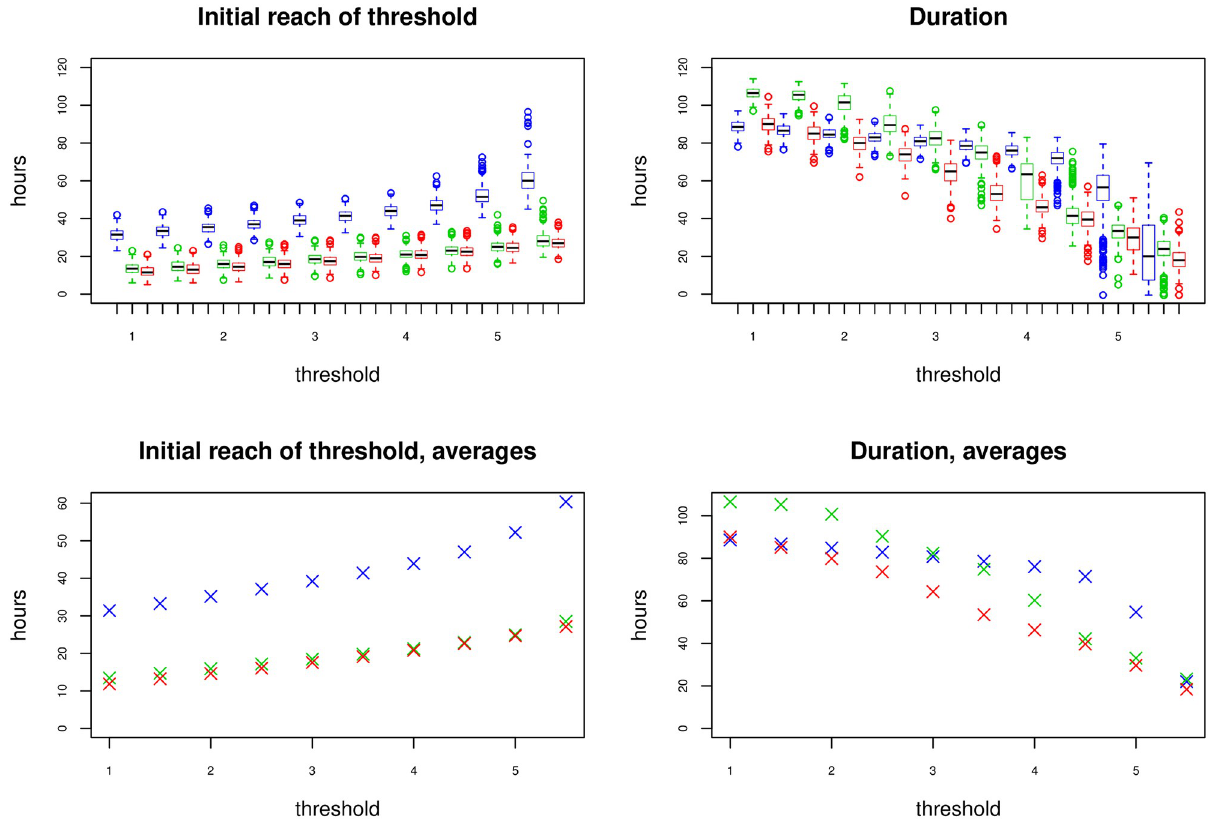
Fig 6. Left: First time conidial discharge intensity reaches given threshold according to the model, for different thresholds. Some trajectories did not reach given thresholds and have been omitted from the corresponding boxplots. Right: Duration that conidial discharge intensity is above given threshold. Blue: 12.0˚C, Green: 18.5˚C, Red: 25˚C.